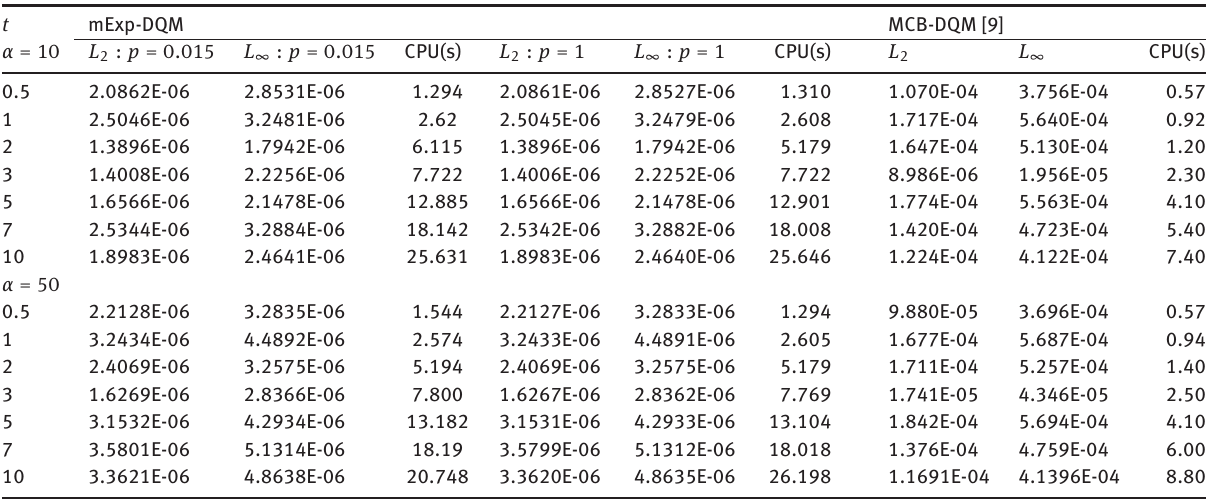
Table 9: Comparison of the mExp-DQM solutions of Example 5.5 with h = 0.1, (cid:2) = 0.01, α = β = 1